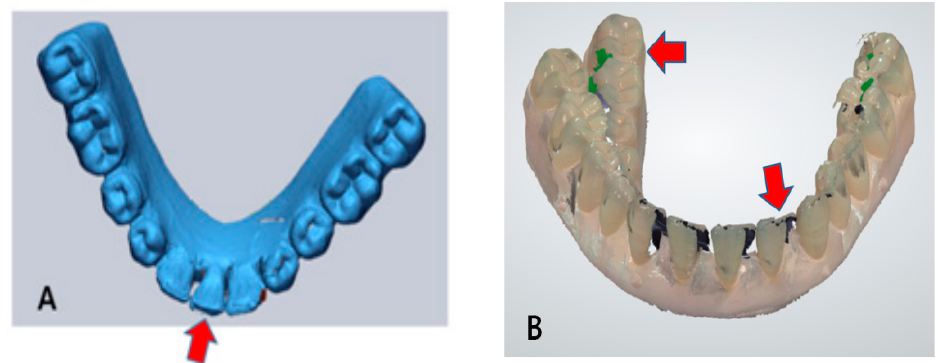
Figure 3. Severely distorted images from iTero ® and Trios ® ( A ) Data from iTero ® : Four anterior teeth were scanned as one anterior tooth. The arch form is distorted; ( B ) Data from Trios ® : lingual area showing severe distortions from the left canine to the right molar. The arch form is significantly constricted.